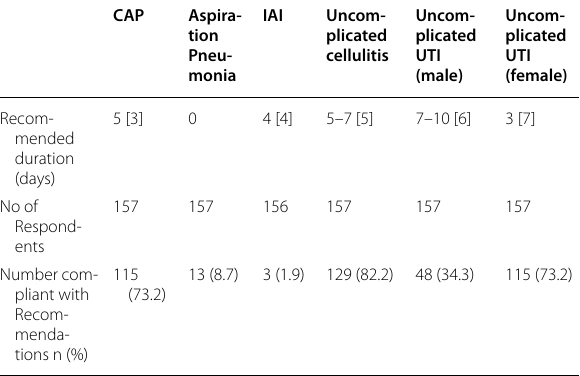
Table 1. Duration of antibiotic prescription (days) with